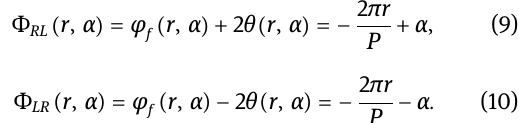
Figure 4: Experimental and simulated performance of the metasurface VVB generator. (A, B) Measured normalized intensity distributions and phase distributions of E xL . (C, D) Measured normalized intensity distributions and phase distributions of E xR . (E – L) Measured normalized intensity distributions of E xx , E 45 ° x , E yx , E − 45 ° x , E xy , E 45 ° y , E yy , and E − 45 ° y , respectively. All the measured results are plottedinthe xy plane at1.1THz.The former and latter inset arrows in the bottom indicate the input and detect polarizations, respectively. The inset fi gures in the top- right positions are the corresponding simulated normalized intensity and phase distributions at 1.0 THz. The diameters of the circles in (E – L) are all 6